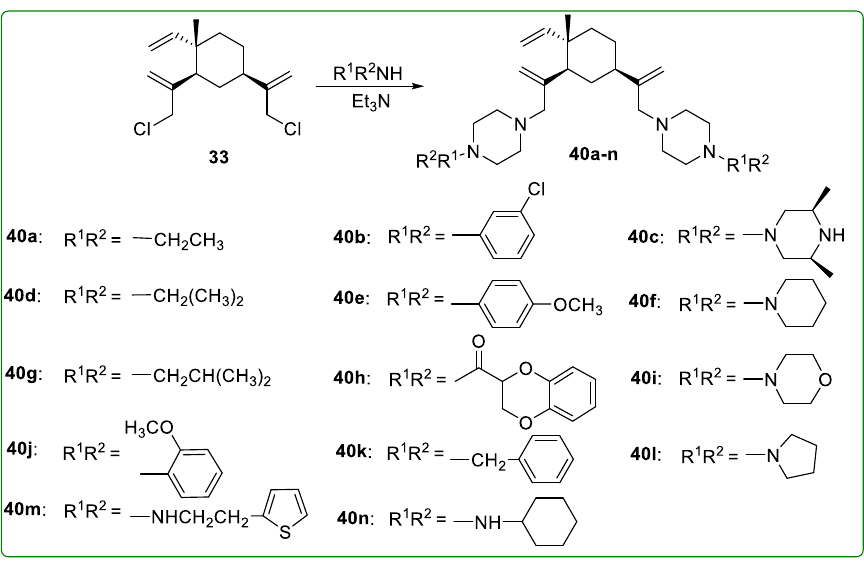
Figure 11. Chemical structures of β -elemene aminated derivatives 40a – n .